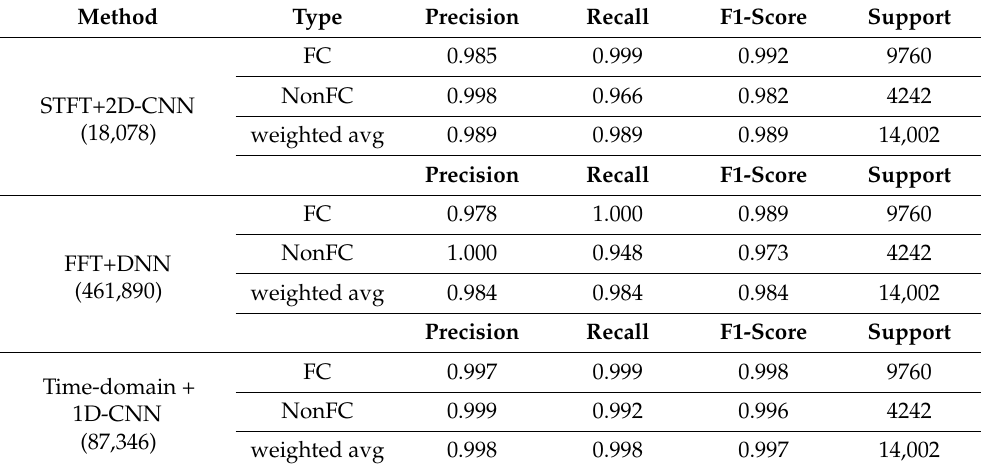
Table 3. Performance of different methods.